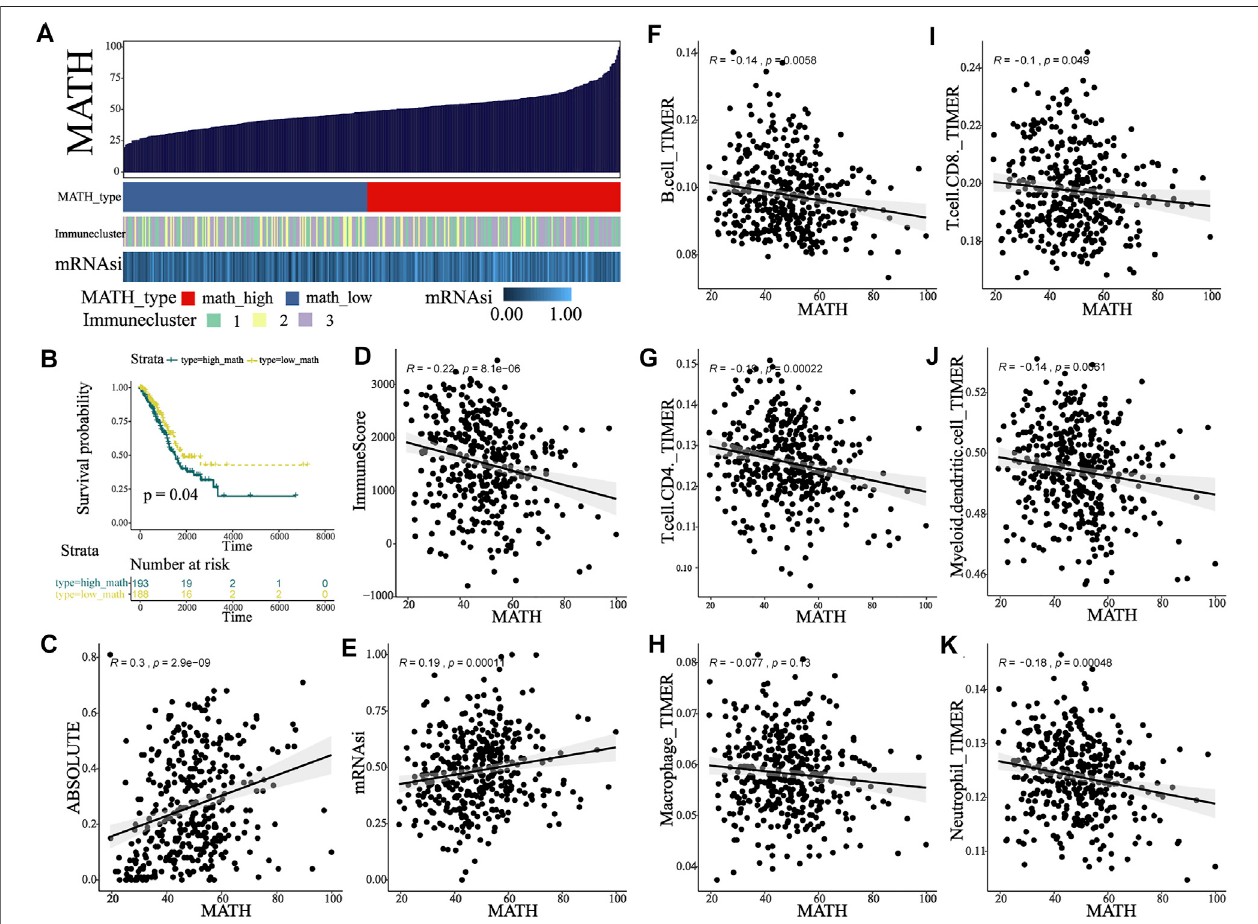
FIGURE 4 | MATH associated with TIME and clinical outcome in early-stage LUAD patients. (A) Calculation ofthe MATH score in the main cohort and an overview of association between MATH and mRNAsi and immunity. (B) Survival analysis indicated signi fi cantly better overall survival in the low-MATH group. (C) Association between MATH and subclonal genome fraction quanti fi ed by ABSOLUTE. (D) Association between MATH and immune-score quanti fi ed by ESTIMATE. (E) Association between MATH and stemness index calculated by OCLR. (F – K) Association between MATH and tumor-in fi ltrating immune cells, including B cell, CD4 T cell, macrophage, CD8 T cell, dendritic cell, and